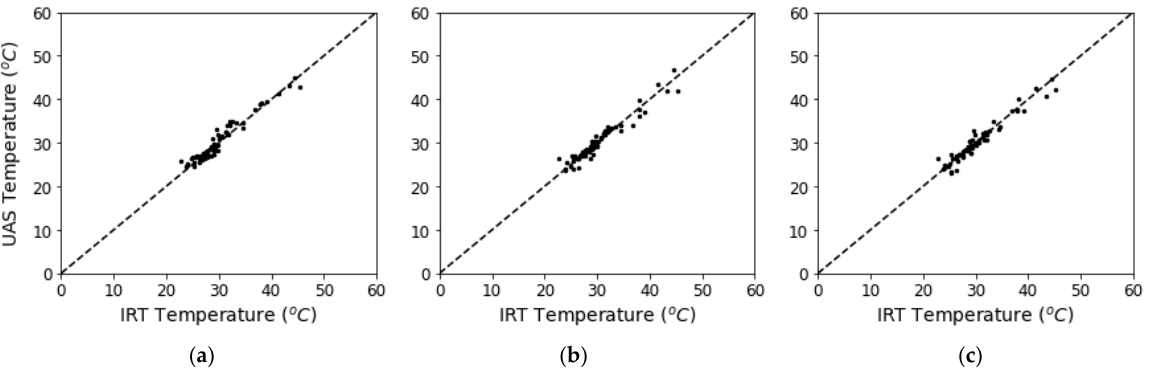
Figure 4. Comparison of ( a ) linear, ( b ) second order polynomial and ( c ) ANN calibrated UAS FDPR thermal imagery with field IRT surface temperature measurements corrected for atmospheric interference. Table 6. Statistical performance of UAS FDPR thermal calibration models. Table 5. Linear (Equation (5)) and second order polynomial (Equation (6)) FDPR calibration model coefficients.